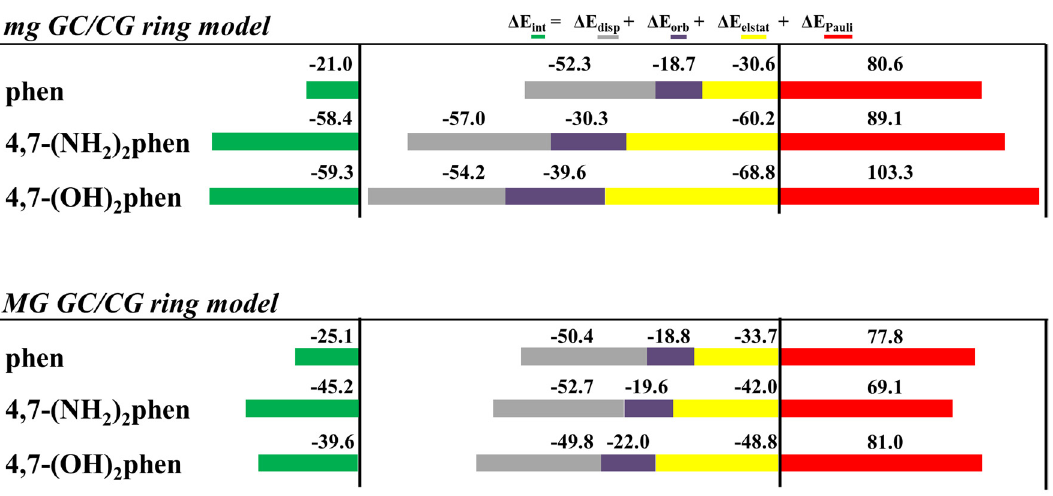
Figure 20. Cumulative bar diagrams for the EDAs associated to the intercalation of phen and hydroxyl and amino derivatives in GCCG bps through the mg and via MG, using ring models. Energies at B3LYP-D3/TZP level of theory in kcal mol − 1 .